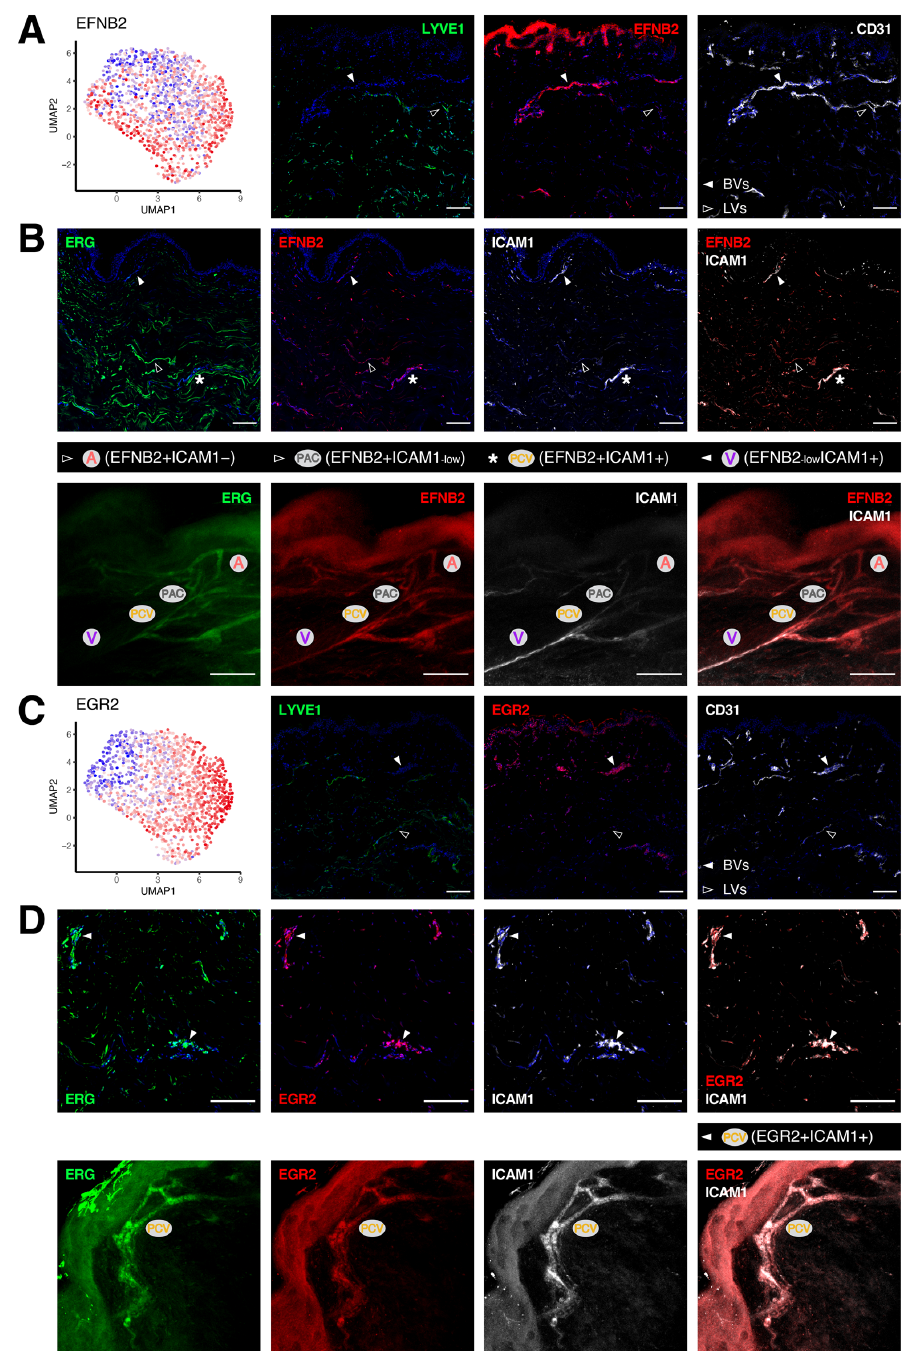
Figure 3. Gene signatures peculiar to the venular compartment. ( A ) EFNB2 expression measured by scRNA-seq (left) and immunofluorescence staining (right) denoting its abundance across different BEC subpopulations and its exclusive expression in human dermal BVs (white arrowheads). ( B ) Representative confocal images of skin sections (upper) and whole-mount skin blocks (lower) stained for ERG (green), EFNB2 (red) and ICAM1 (white). The unique composition of EFNB2 and ICAM1 expression enables the discrimination of arterioles (empty arrowheads), post-capillary venules (*) and venules (white arrowheads). ( C ) EGR2 expression is most enriched in the post-capillary venule cluster and is restricted to BVs (white arrowheads). ( D ) Representative section (upper) and whole-mount staining (lower) of ERG (green), EGR2 (red) and ICAM1 (white), highlighting EGR2+ICAM1+ BVs. Scale bars: 100 µ